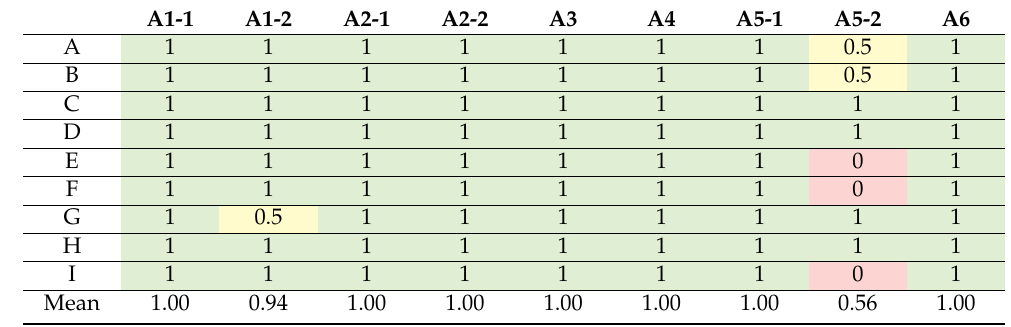
Table 9. Acceptance levels for each key idea. Ax stands for the acceptance level of the student with regard to key idea x, cf. Tables A1–A6. The responses are color coded such that 1 is green, 0.5 is yellow and 0 is red.